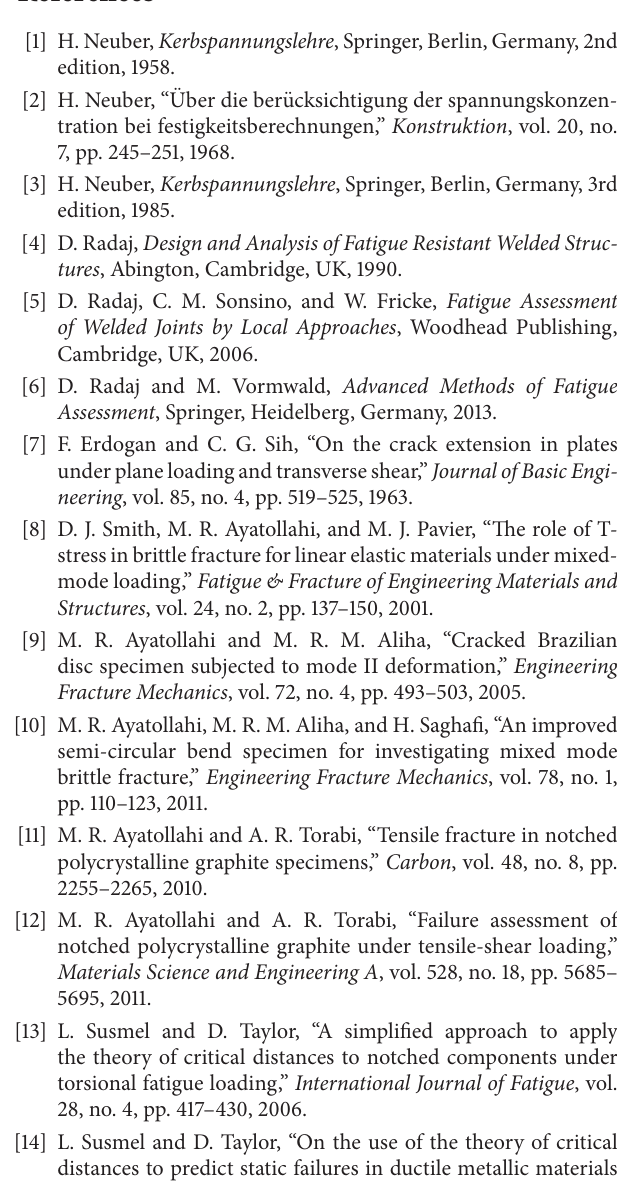
Figure 8: Proof of equivalent local mode